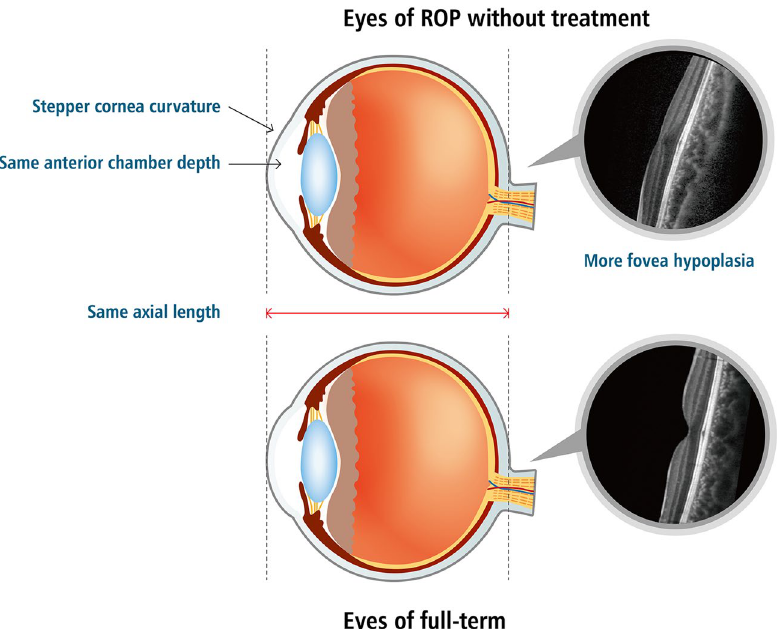
Figure 2. Comparison of optical-component characteristics and fovea status between patients with retinopathy of prematurity (ROP) who had not received treatment and full-term